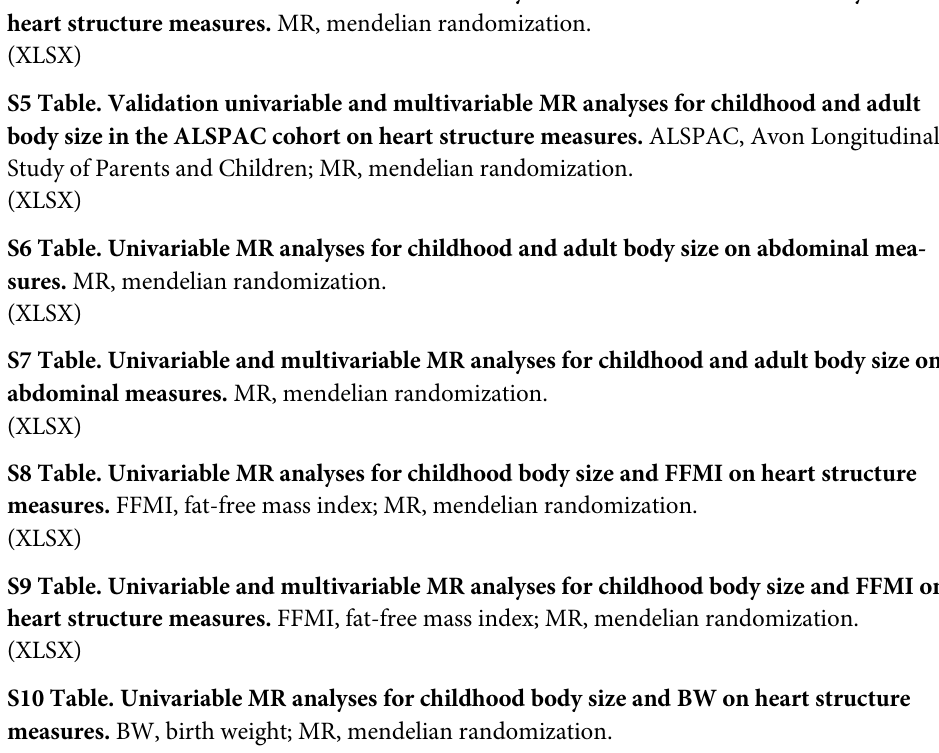
S2 Table. Characteristics for the exposures and outcomes analyzed in this study. S3 Table. Univariable MR analyses for childhood and adult body size on heart structure measures. MR, mendelian randomization. S4 Table. Univariable and multivariable MR analyses for childhood and adult body size on heart structure measures. MR, mendelian randomization. S5 Table. Validation univariable and multivariable MR analyses for childhood and adult body size in the ALSPAC cohort on heart structure measures. ALSPAC, Avon Longitudinal Study of Parents and Children; MR, mendelian randomization. S6 Table. Univariable MR analyses for childhood and adult body size on abdominal mea- sures. MR, mendelian randomization. S7 Table. Univariable and multivariable MR analyses for childhood and adult body size on abdominal measures. MR, mendelian randomization. S8 Table. Univariable MR analyses for childhood body size and FFMI on heart structure measures. FFMI, fat-free mass index; MR, mendelian randomization. S9 Table. Univariable and multivariable MR analyses for childhood body size and FFMI on heart structure measures. FFMI, fat-free mass index; MR, mendelian randomization. (XLSX) S10 Table. Univariable MR analyses for childhood body size and BW on heart structure measures. BW, birth weight; MR, mendelian randomization. S11 Table. Univariable and multivariable MR analyses for childhood and BW on heart structure measures. BW, birth weight; MR, mendelian randomization. S12 Table. Univariable MR analyses for childhood and adult height on heart structure measures. MR, mendelian randomization. S13 Table. Univariable and multivariable MR analyses for childhood and adult height on heart structure measures. MR, mendelian randomization. S14 Table. Univariable and multivariable MR analyses for childhood body size and child- hood height on heart structure measures. MR, mendelian randomization. S15 Table. Univariable MR analyses for childhood and adult body size on risk of cardiomy- opathy outcomes. MR, mendelian